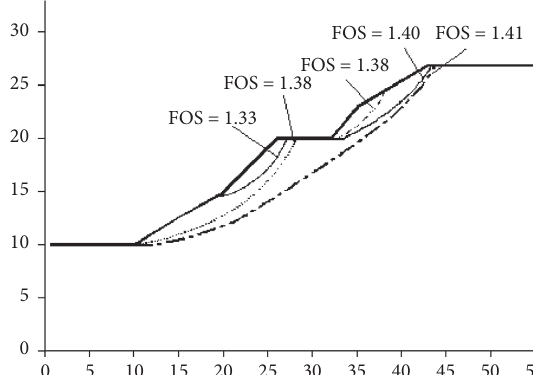
Figure 4: The multiple failure slip surfaces with minimum FS � 1.33 in LEM.